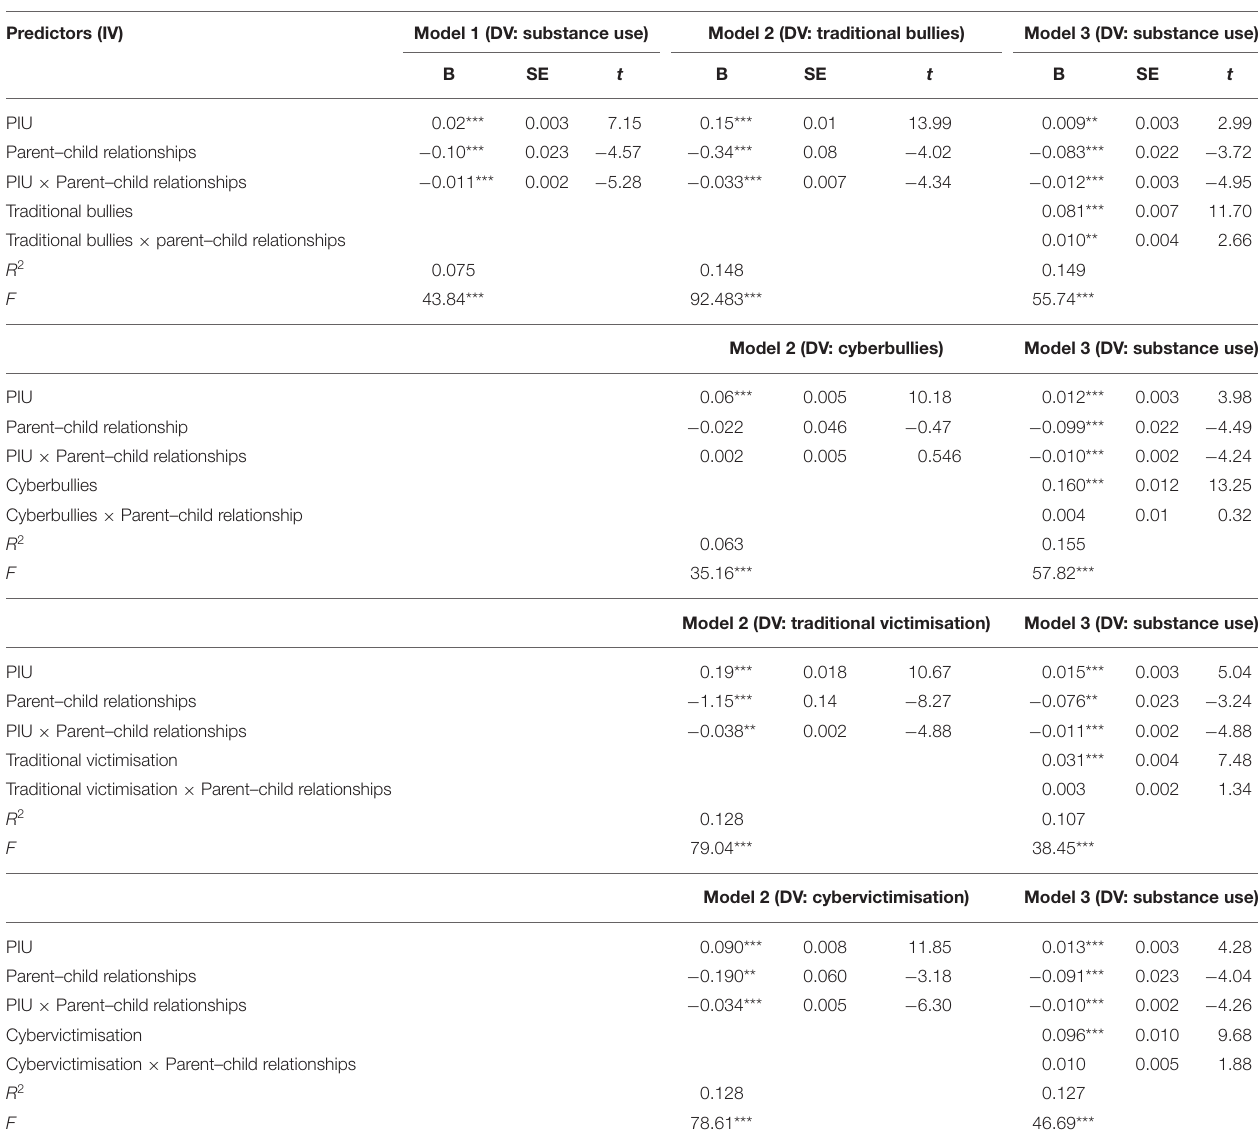
TABLE 3 | Regression model summary of the moderation-mediation model predicting substance abuse. Predictors (IV) Model 1 (DV: substance use) Model 2 (DV: traditional